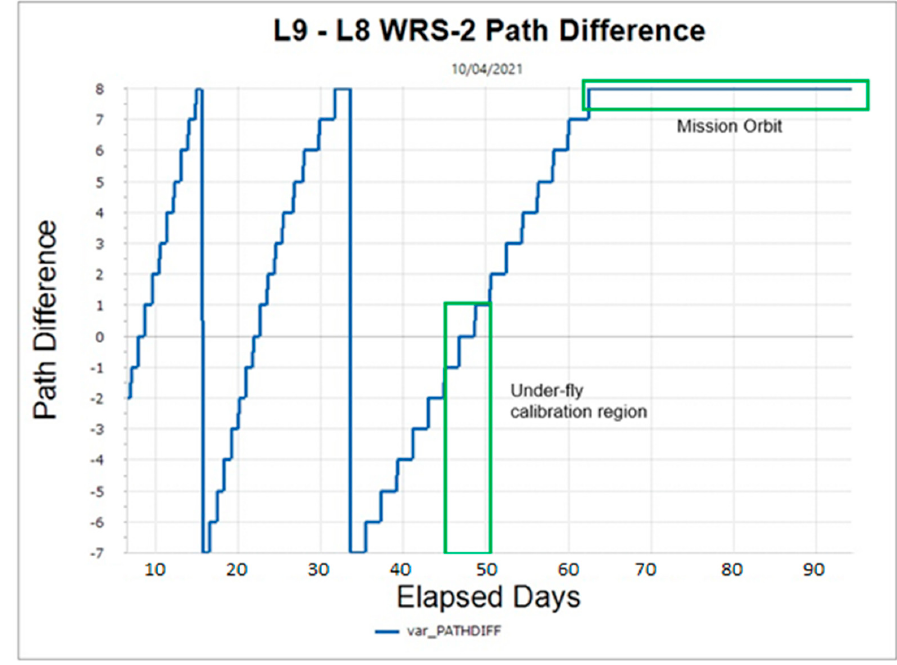
Figure 4. Landsat 9 offset from Landsat 8 in WRS-2 path difference.